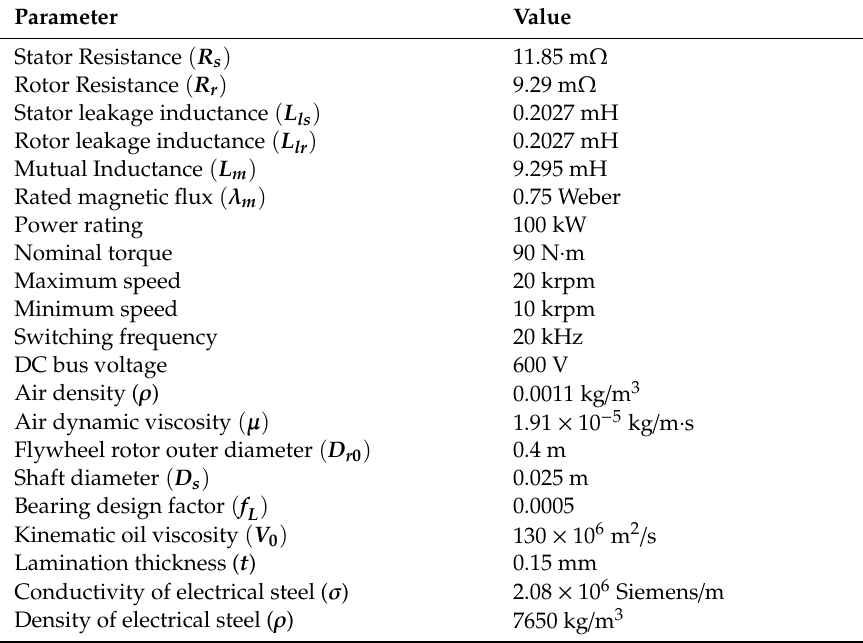
Table 2. Values of coe ffi cients and parameters of